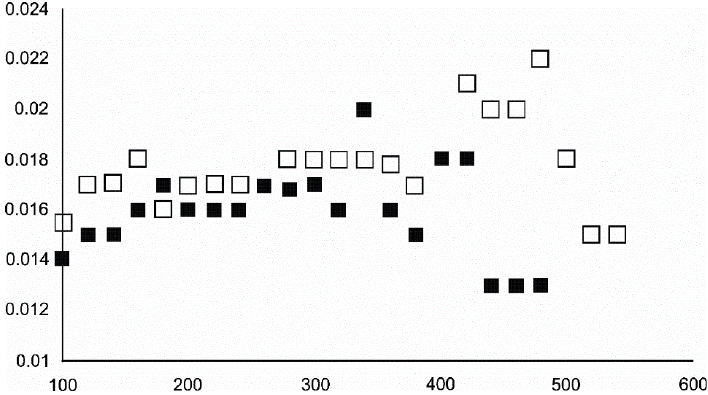
Figure 7. Relation of the full-width half-maximum (FWHM) parameter of siderite (in 2 θ degrees, based on the 104 reflection) to temperature (bottom axis, °C). LSCB—filled symbols. USCB—empty symbols.